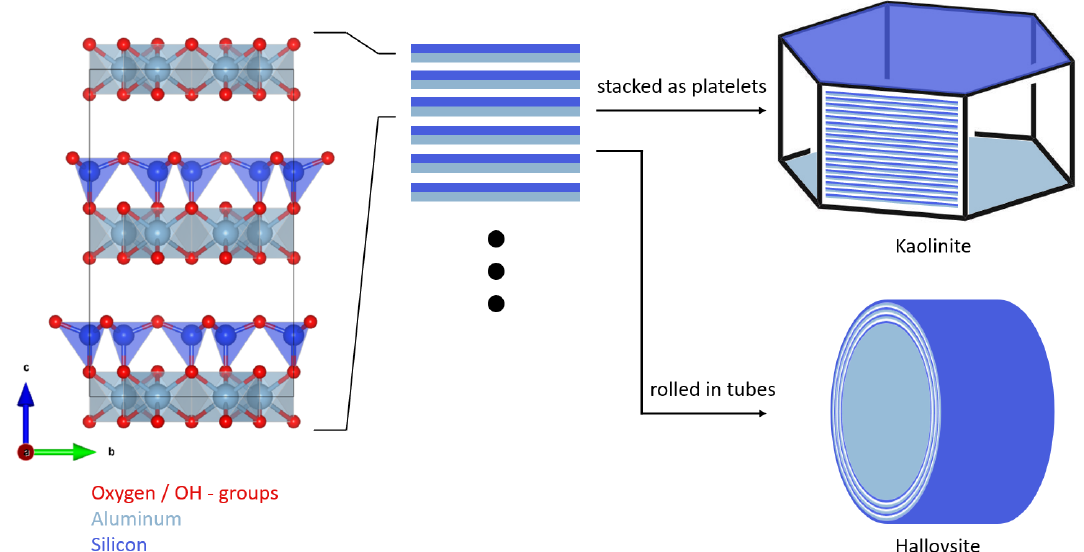
Figure 1. Schematic structure and particle morphology of kaolinite and halloysite. The left column shows the unit cell of kaolinite/halloysite (generated with VESTA 3, Momma and Izumi, 2011, using data from Gruner, 1932). The stacking of multiple layers either results in hexagonal platelets in the case of kaolinite or rolled tubes in the case of halloysite. Please note the schematic nature of this figure, as the dimensions depicted here do not necessarily resemble the true dimensions in a